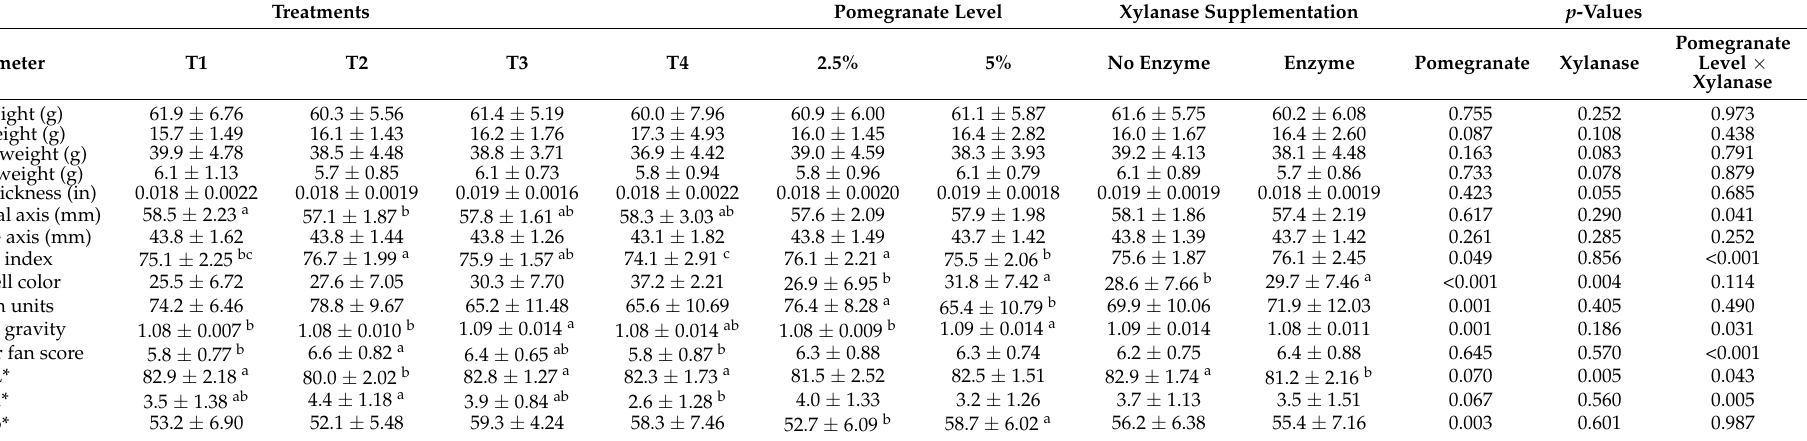
Table 3. Effects of two levels of pomegranate peel byproduct with or without xylanase on egg quality parameters. T1: 2.5% PPB; T2: 2.5% and xylanase; T3: 5% PPB; T4:5% PPB and xylanase. Values are means ± SD ( n = 24 per treatment).